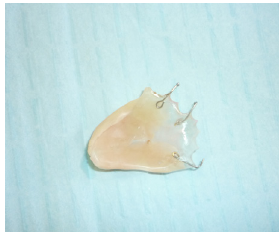
Figure 6. Palatal plate detail.